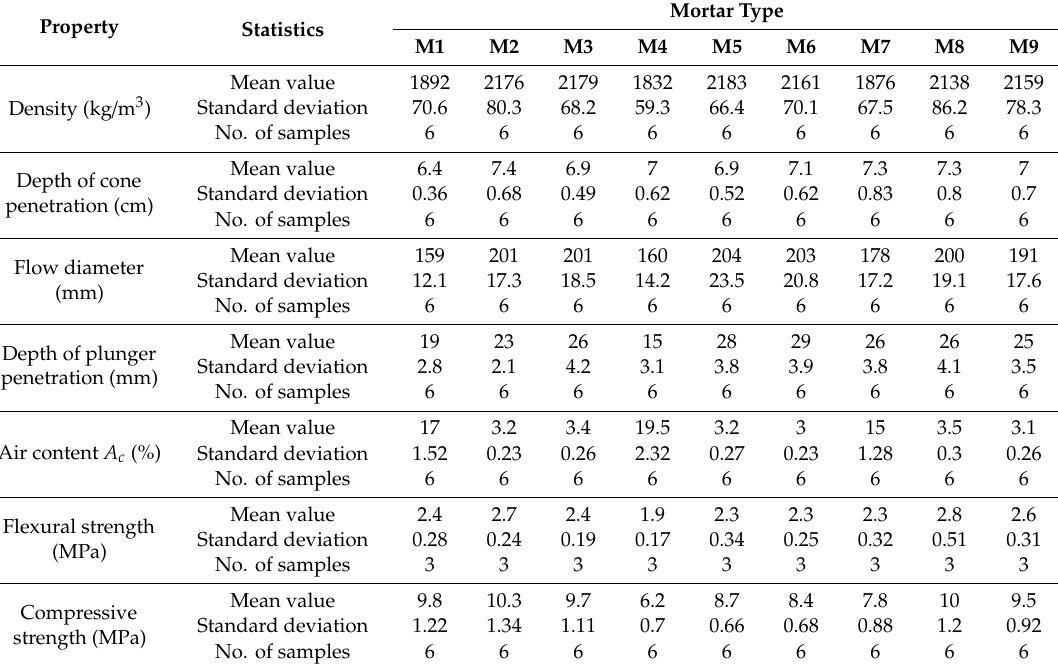
Table 6. Results of tests of the influence of cement type on properties of masonry